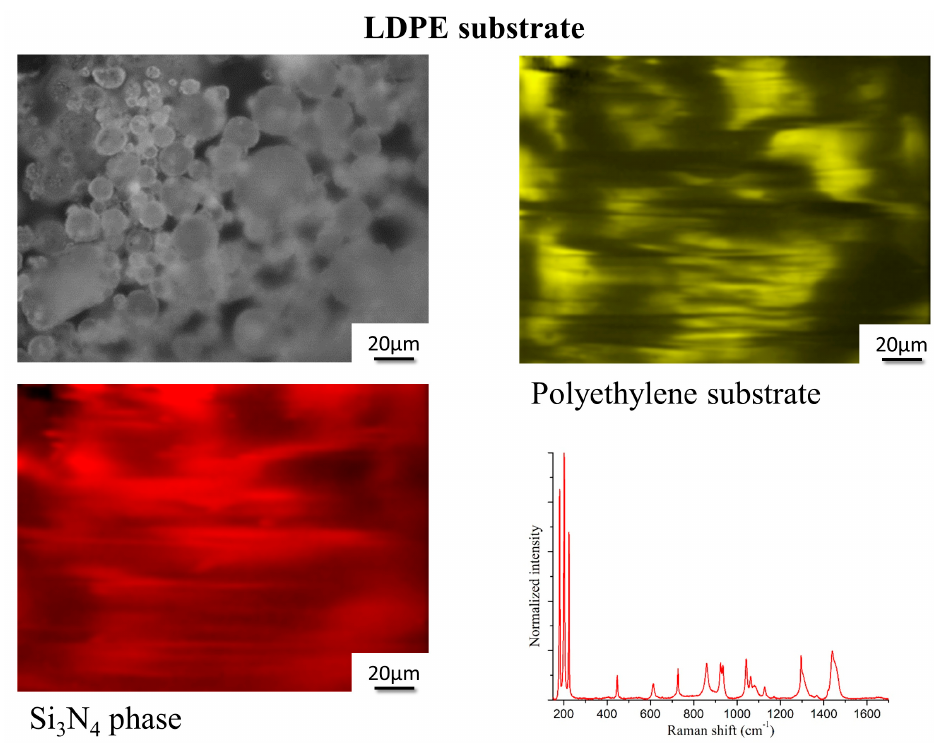
Figure 3. Raman imaging maps and Raman spectra of coated LDPE substrate.